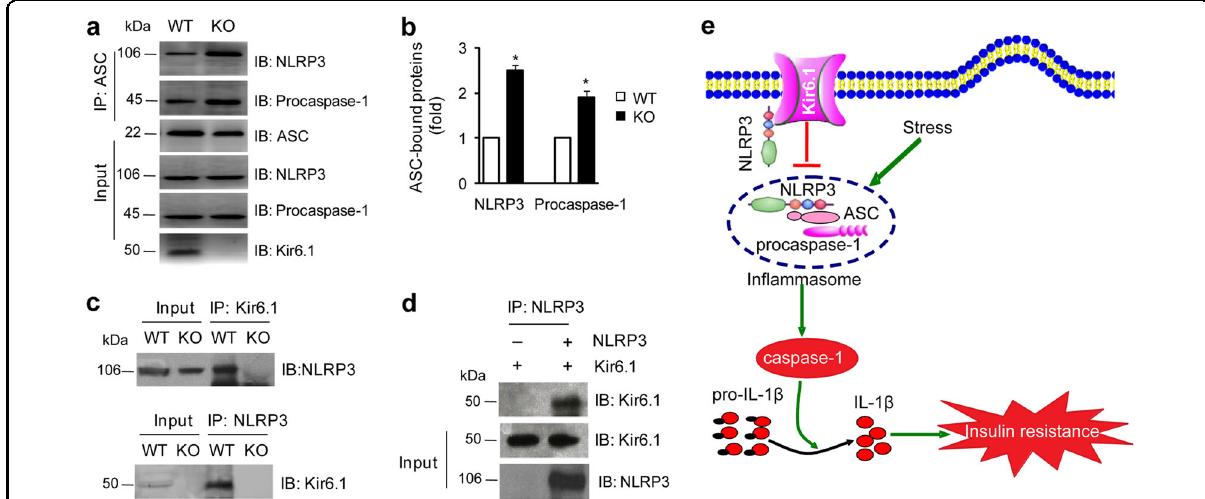
Fig. 7 Kir6.1 inhibits NLRP3 in fl ammasome assembly and interacts with NLRP3. a The interaction of ASC with NLRP3 and procaspase-1 in BMDMs isolated from WT and Kir6.1 KO mice assessed by co-IP. b Quanti fi cation of data shown in ( a ); n = 4. The data shown are the mean ± SEM. * p < 0.05 vs WT. c The interaction of Kir6.1 with NLRP3 assessed by co-IP in BMDMs isolated from WT and Kir6.1 KO mice. d The interaction of Kir6.1 with NLRP3 assessed by co-IP in HEK293T cells transfected with NLRP3 and Kir6.1. e A model depicting the roles of Kir6.1, via its interaction with NLRP3, in inhibiting the assembly and activation of the NLRP3 in fl ammasome, as well as insulin